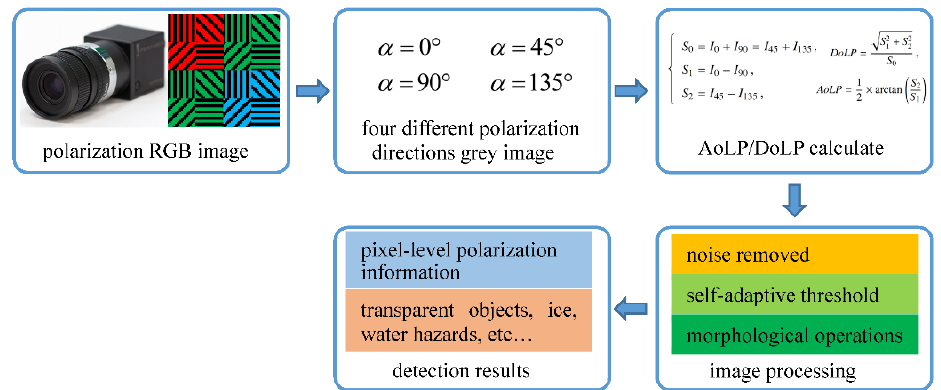
Figure 4. The processing procedure of polarization color images.